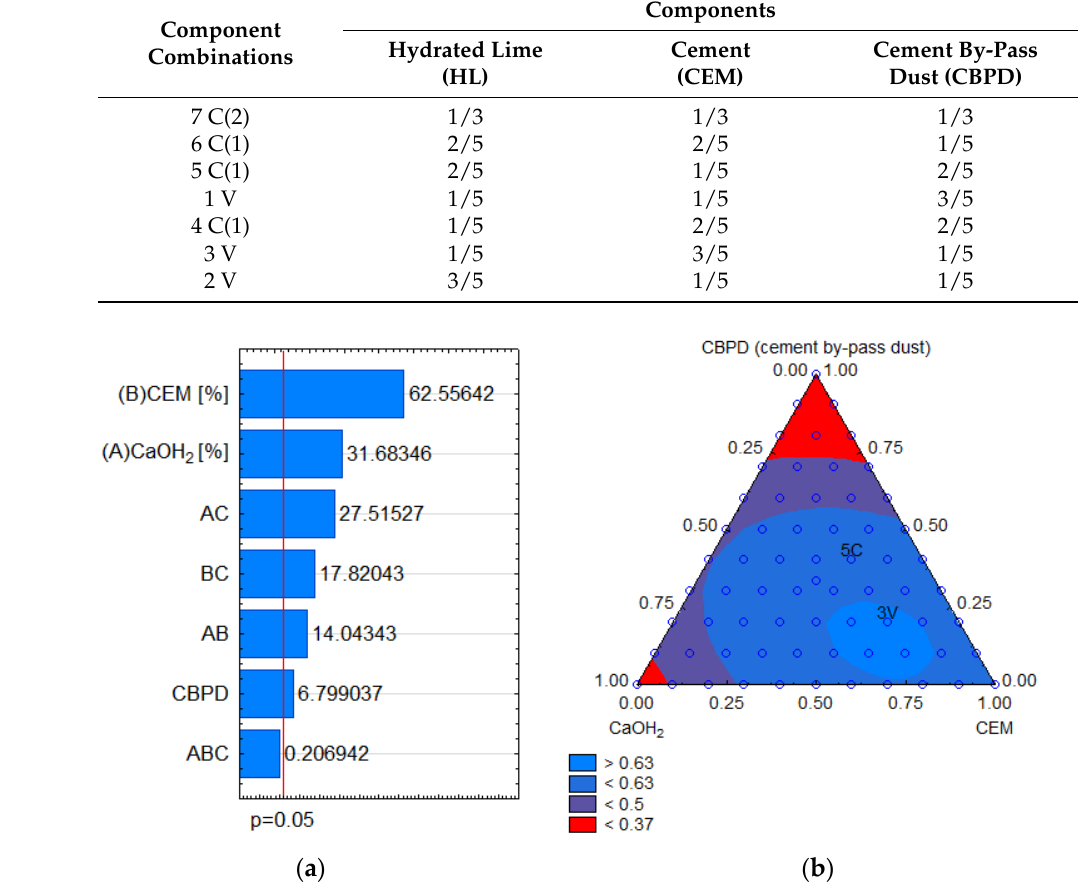
Table 1. Quantity of components of a universal binder based on the mixture design with constraints.